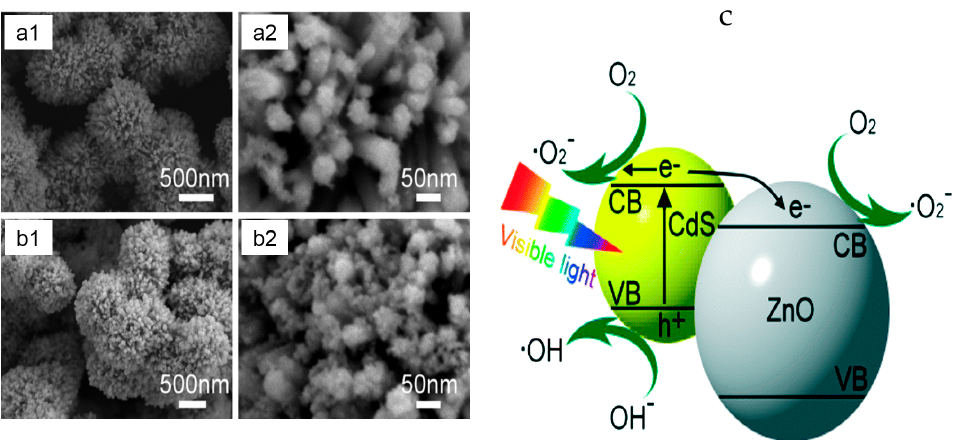
Figure 5. ( a , b ) SEM images of urchin ‐ like Fe 3 O 4 @SiO 2 @ZnO/CdS microspheres and ( c ) charge transfer route in Fe 3 O 4 @SiO 2 @ZnO/CdS. Reproduced with permission from [140]. Copyright 2016, RSC.